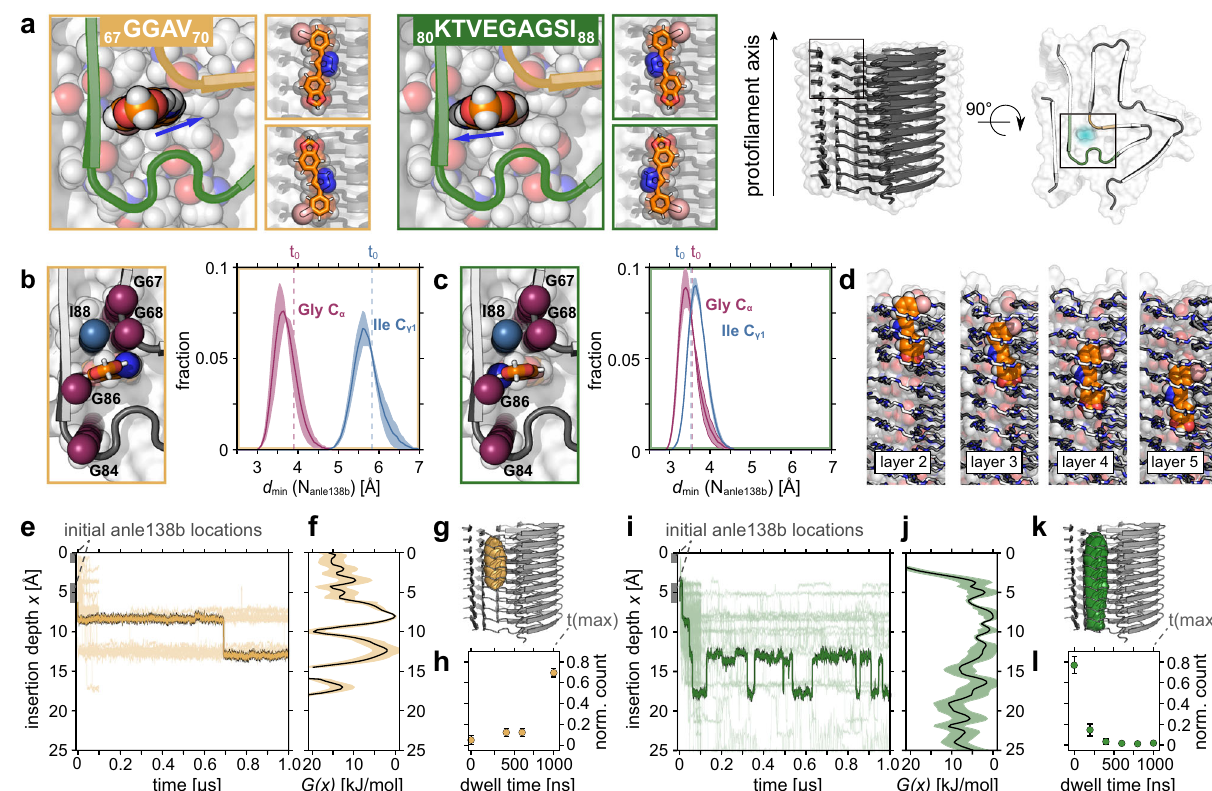
Fig. 3 | Anle138b binds dynamically inside the α -synuclein proto fi lament. a Starting structures for MD simulations for the four principal poses of anle138b: Pyrazolenitrogenatoms of anle138b(indicatedby blue arrows)are oriented either to residues 67 GGAV 70 (inward-facing, yellow) or to residues 80 KTVEGAGSI 88 (out- ward-facing, green) inside the cavity (cyan) of α -synuclein proto fi lament L2. The bromophenyl moiety can point up or down the proto fi lament (small panels). A color code denotes the individual simulation sets for each binding pose in all following panels (inward-facing — yellow, outward-facing — green). b , c Orientation (left) and distributions of minimal distances (right) between nitrogen atoms of anle138b and C γ 1 of I88 (light-blue), and C α of G67, G68, G84, G86 (magenta) as described in a . Dashedlines indicate the initial positions of anle138b atthe start of